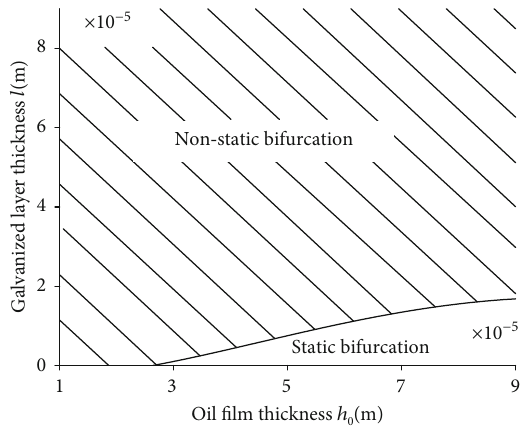
Figure 8: Bifurcation scope diagram.